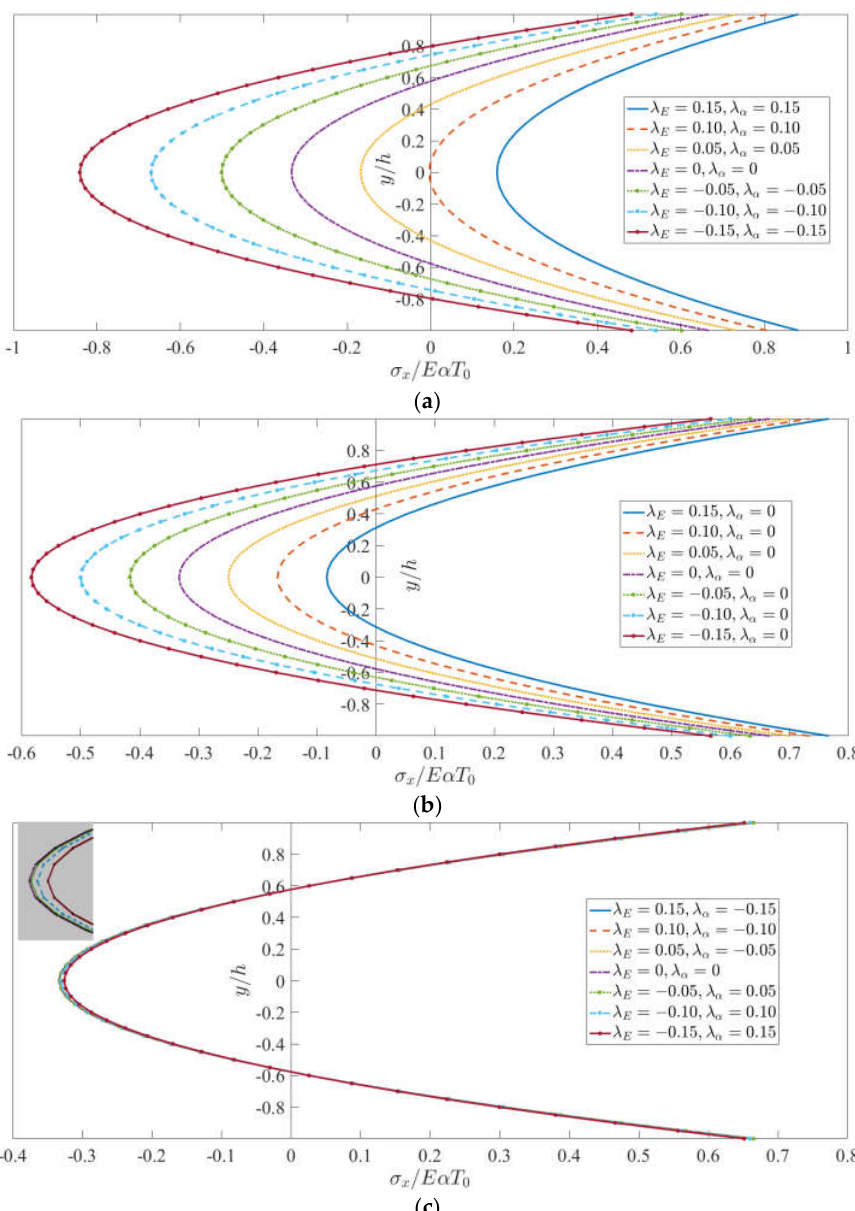
Figure 6. Thermal stresses of Case 2: ( a ) when the variation trend of λ E and λ α is consistent, ( b ) when λ α = 0 and ( c ) when the variation trend of λ E and λ α is the opposite.